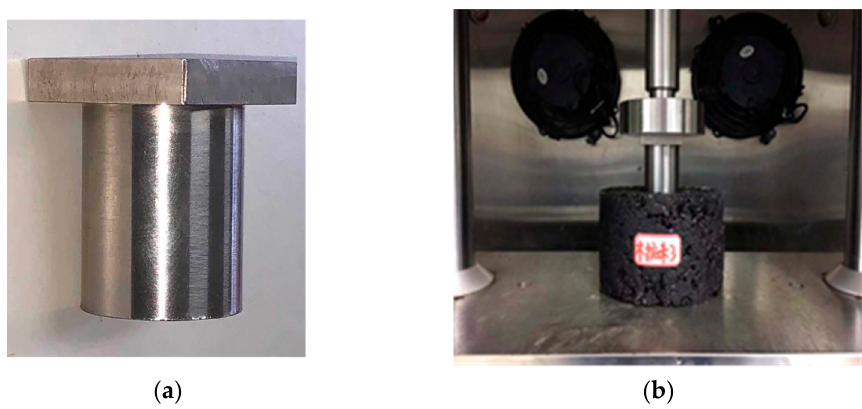
Figure 4. Images of the uniaxial penetration test: ( a ) steel plunger and ( b ) test process.